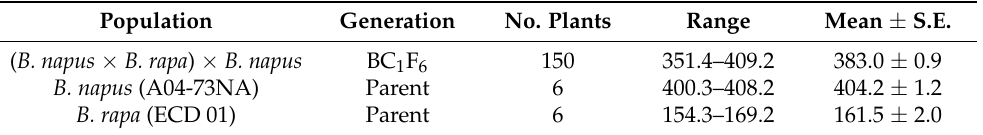
Table 2. Partec values for the relative nuclear DNA content in the BC 1 F 6 population of the ( B. napus × B. rapa ) × B. napus interspecific cross.